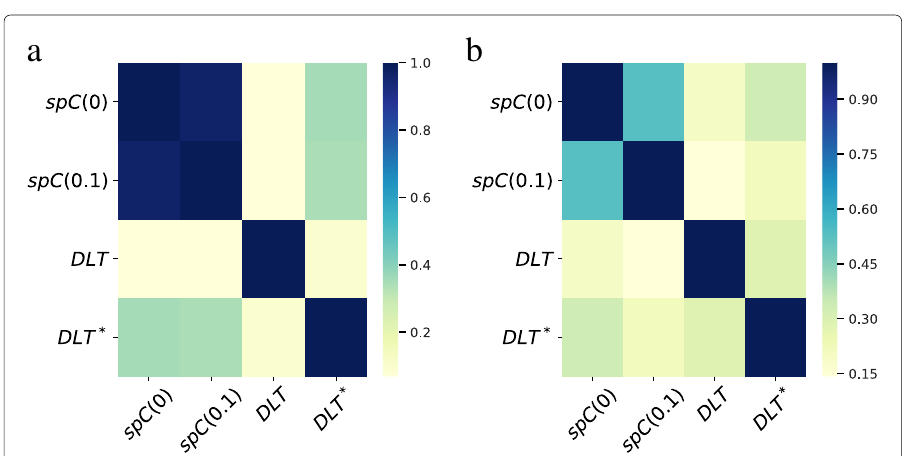
Fig. 17 spC - F 2 DLT vs. DLT: overlap percentages at convergence of the two models, on Slashdot. a I-Sources. b